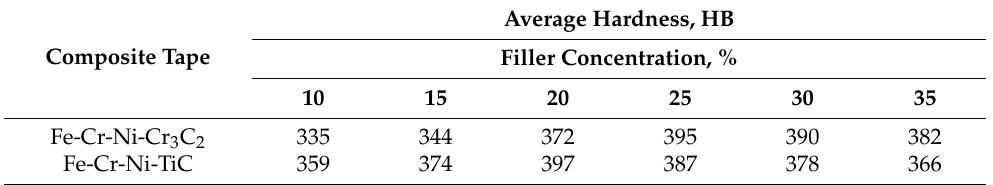
Table 1. Dependence of the hardness of the composite tapes of the filler concentration.